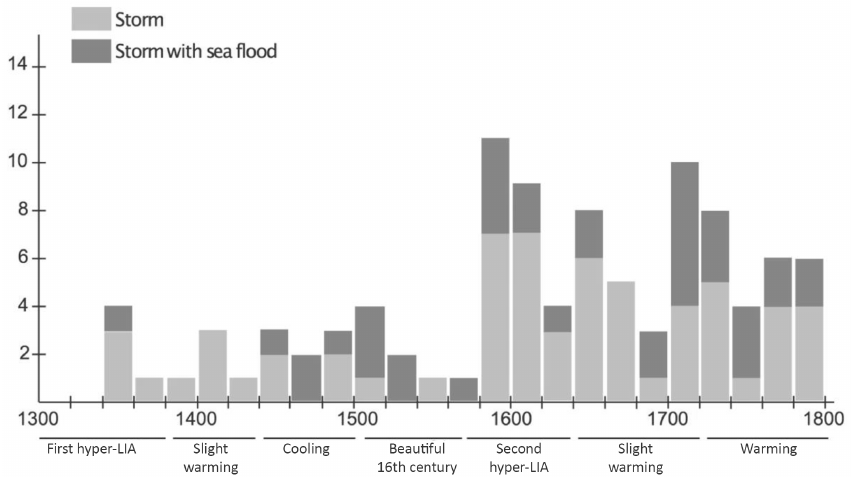
Figure 2. Number of storms and storms with sea floods in the study area.